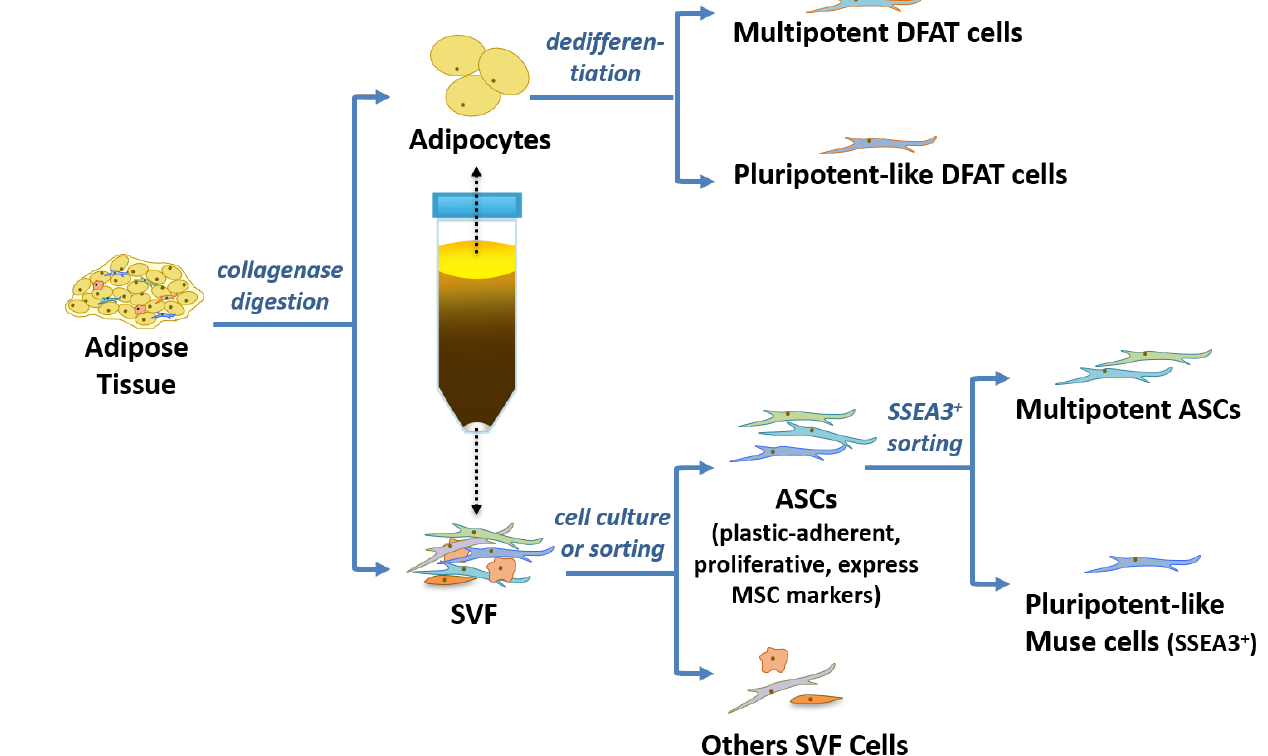
Figure 1. Adipose tissue is a source of diverse cell types for application in regenerative medicine. Adipocytes are separated from the stromal vascular fraction (SVF) by collagenase digestion and centrifugation. Adipose-derived stem cells (ASCs) expanded in culture display characteristics of mesenchymal stem cells (MSCs) but are still heterogeneous (Sections 6 and 7). Sorting of ASCs by SSEA3 expression isolates multilineage-differentiating stress-enduring (Muse) cells (Section 8). Dedifferentiated fat (DFAT) cells can be generated from floating adipocytes using ceiling culture or cell filter methods (Section 9).